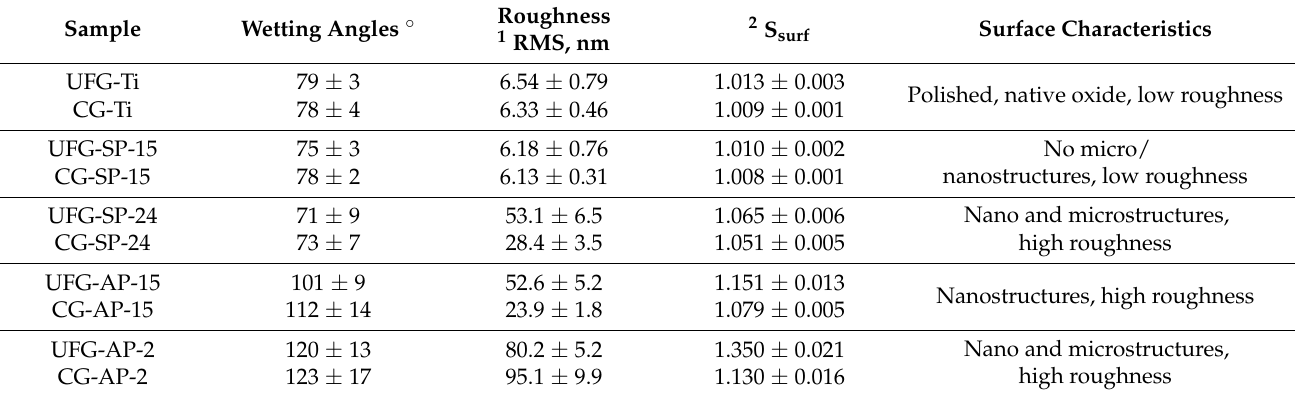
Table 1. Wettability and surface topography parameters of the